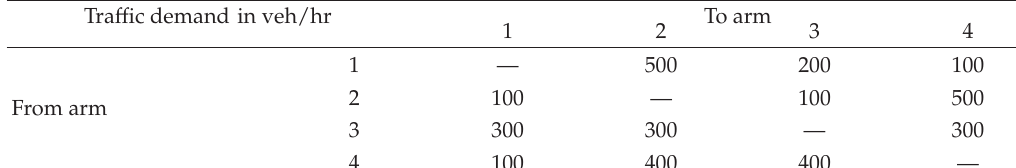
Table 1: The tra ffi c demand for the example junction.